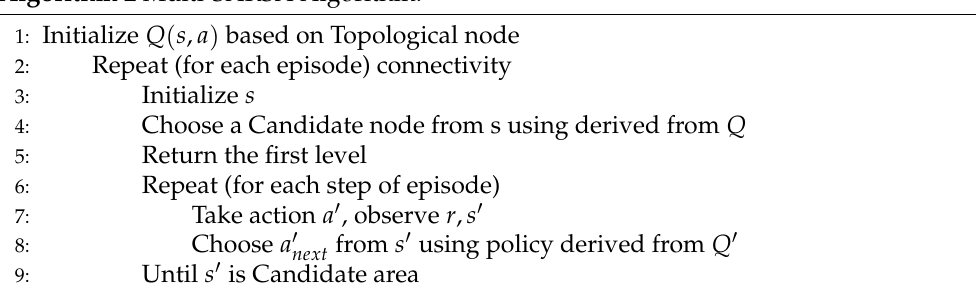
Figure 8. The ( left picture ) is an angle diagram inspired by DWA, and θ 1 − θ 0 in the picture is the angle difference needed; the ( middle picture ) is a comparison diagram of Euclidean distance and Manhattan distance; and the ( right picture ) is a distance diagram, in which dia tan ce _1 − dis tan ce _0 is dia tan ce ( v , w ) in the function. Algorithm 2 Multi-SARSA